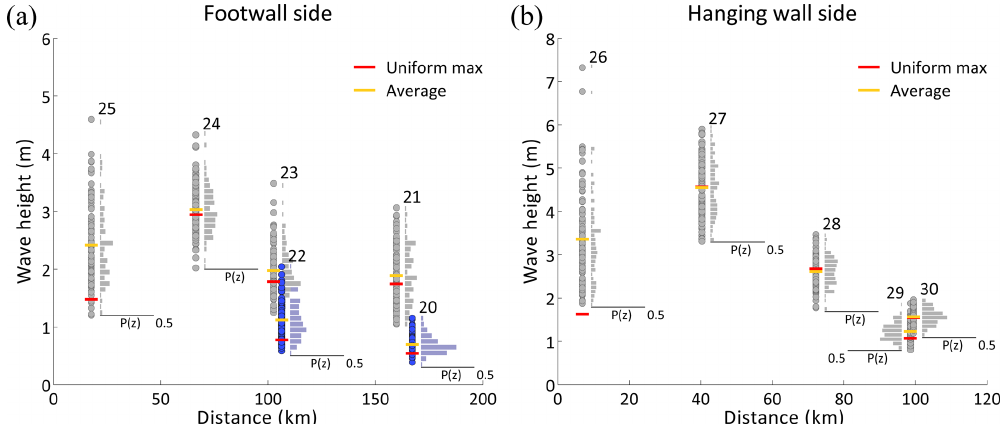
Figure 6. The relation between the distance and wave height for stations 20 to 30 in eastern Taiwan. Panel (a) is the station on the footwall side. Stations 20 and 22 (blue color) are off the shoreline of Taiwan. Panel (b) represents the stations on the hanging wall side. Both sides roughly exhibit a linear decay and range of uncertainty converging with increasing distance for the tsunami amplitude. Red bars show the PTA of the uniform slip distribution, and yellow bars show the average of the PTAs from the stochastic slip